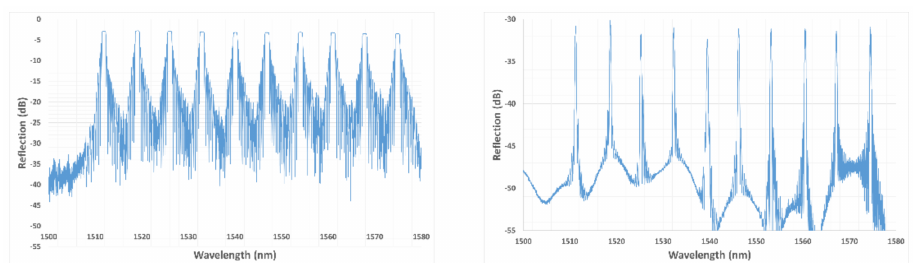
Figure 6. Reflection spectra before and after regeneration for a line of ten wavelength-multiplexed Fiber Bragg Gratings. The regeneration has been realized at CEA List using a three heating zones tubular furnace on an FBG array written in H 2 -loaded smf-28 optical fibre and a KrF laser emitting at 248 nm.